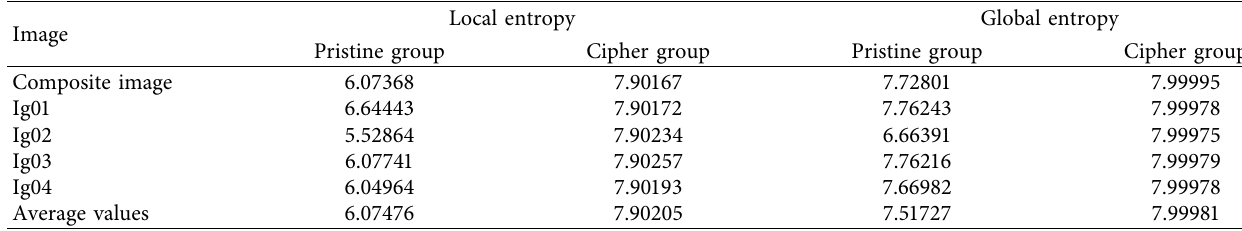
Table 3: Local and global information entropies of the studied dataset.